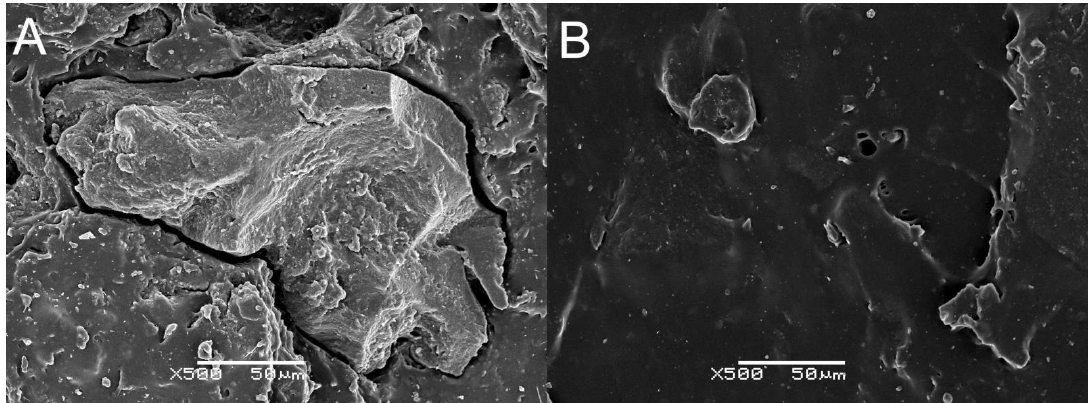
Figure 7. SEM images of samples: ( A ) NR/GTR100 S , ( B ) NR/GTR100 P (magnification ×500).